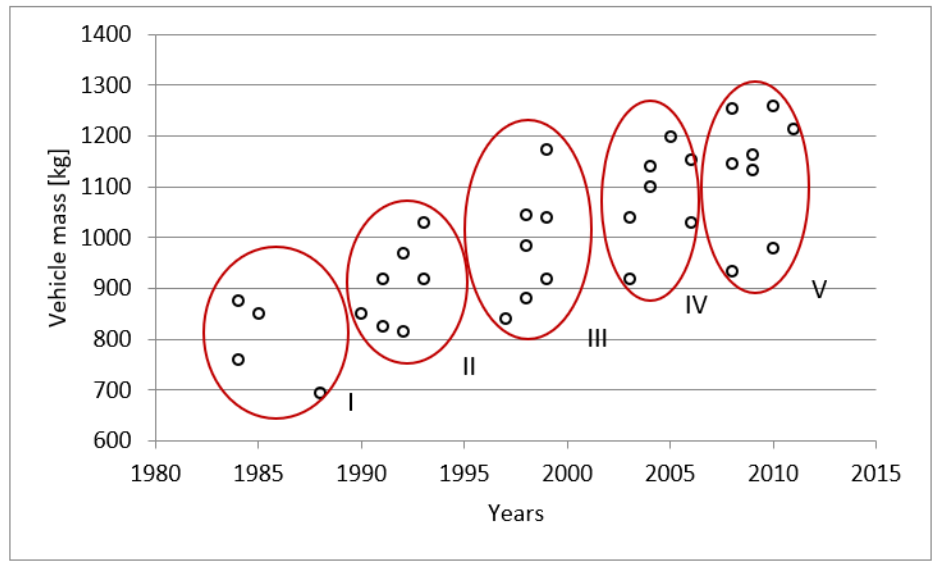
Figure 2. Mass dispersion of passenger cars in relation to the year of production. Table 1. Spearman’s rank correlation results for vehicle weight and year of production. A Pair of Variables: Mass and